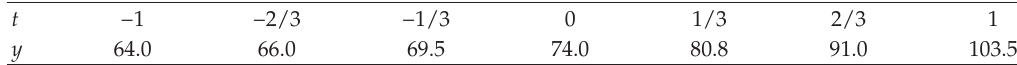
Table 3: Data of Case 2 (cid:3) A second-order system (cid:4) .